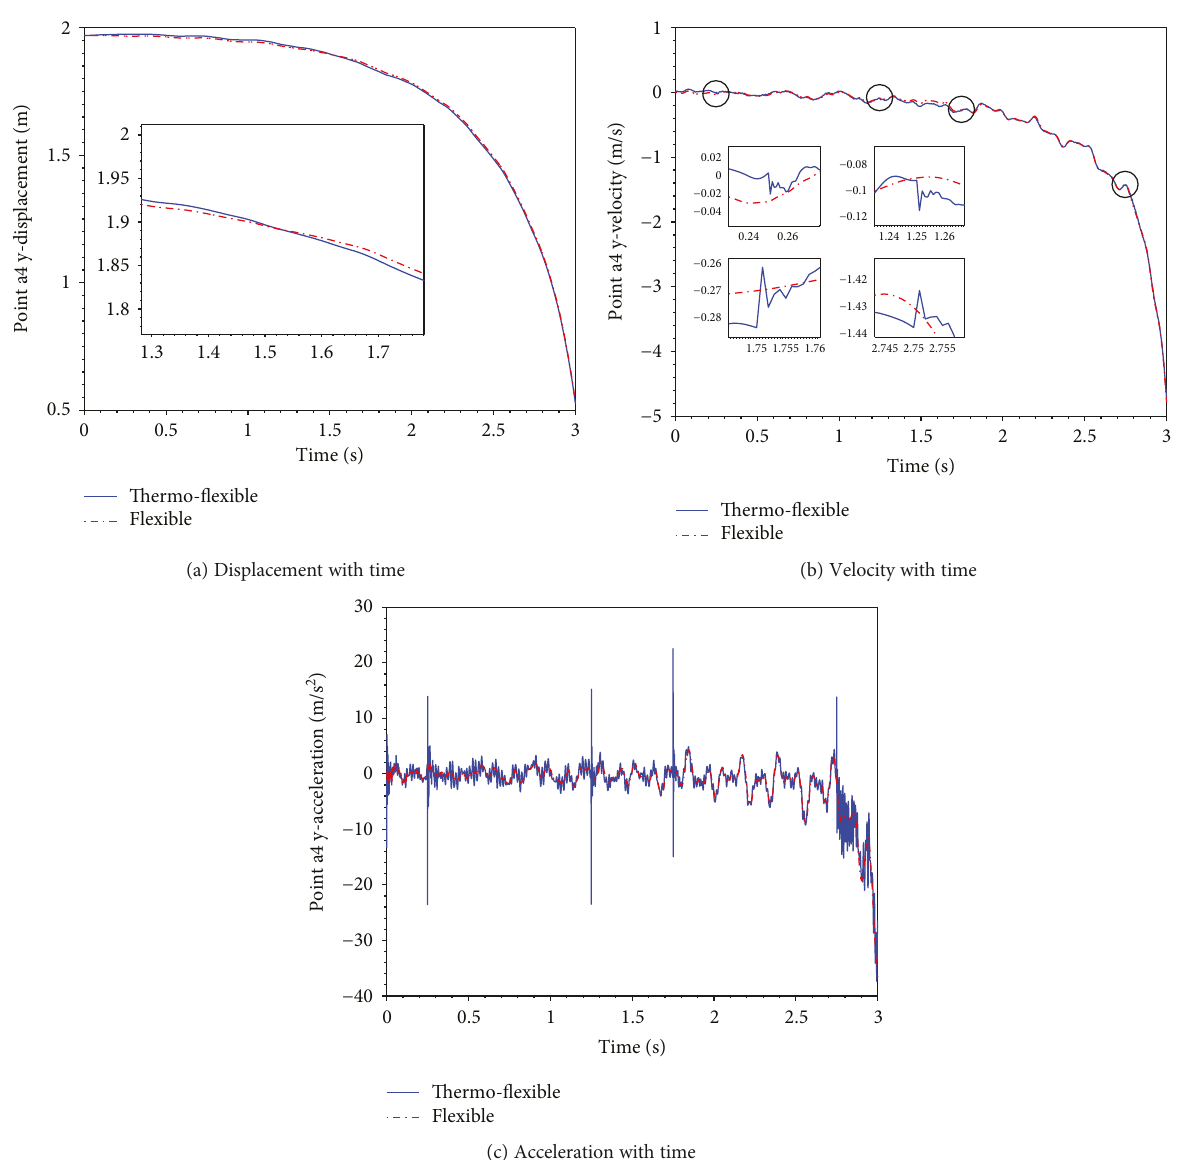
Figure 8: Deployment dynamics characteristics of the